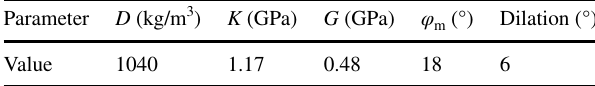
Table 5 Material parameters of the double-yield model